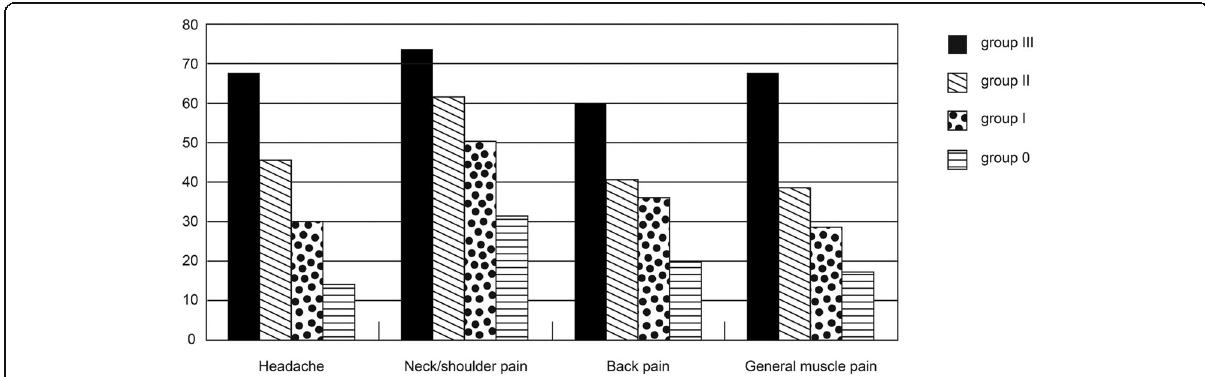
Fig. 1 Self-reported percentages of time with pains in the past ten years in different groups. Group III, II, I, and 0 represent patients who had migraine at all, any two, any one, and none of the three time points (including baseline, the two-year point, and the ten-year point), respectively. Significant differences were noted between the four groups in terms of the four pain symptoms